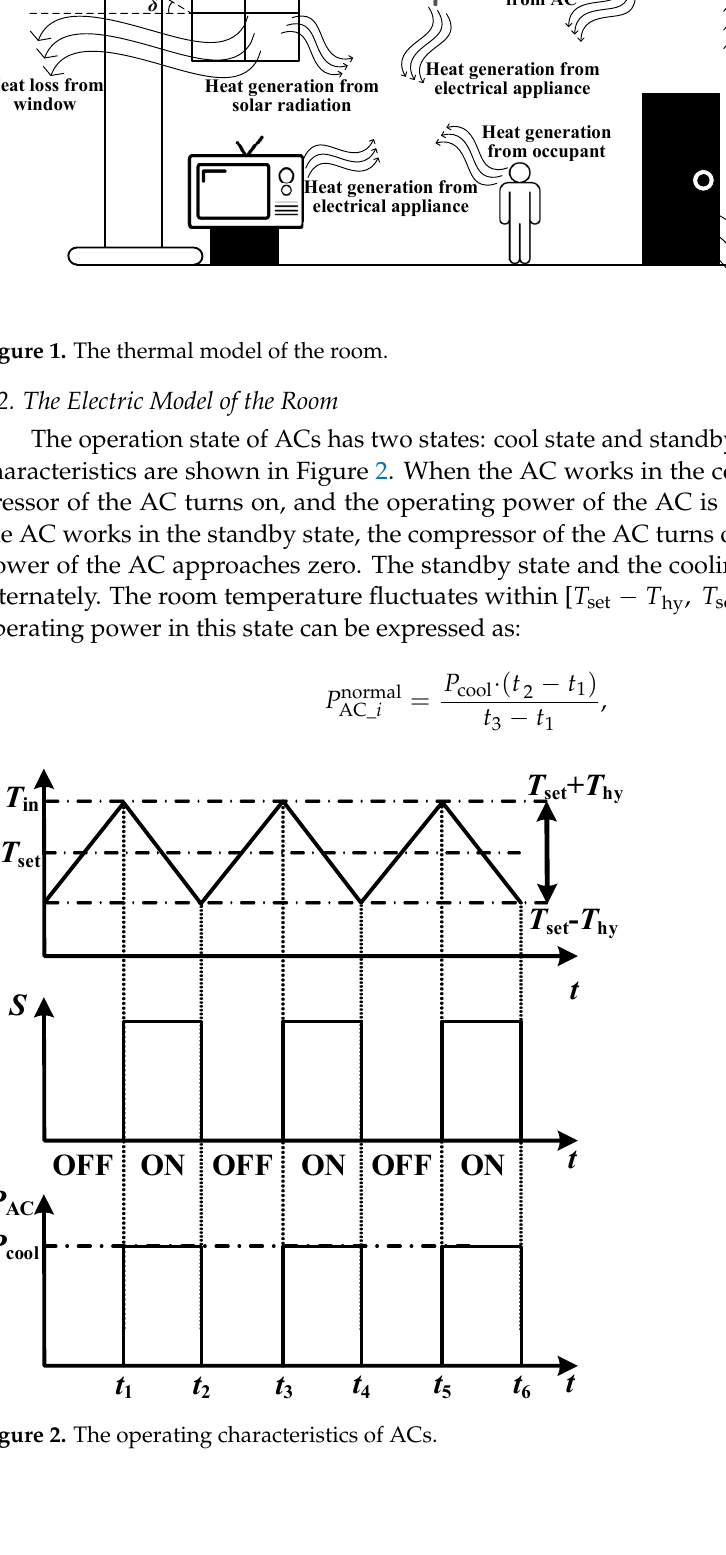
Figure 1. The thermal model of the room.